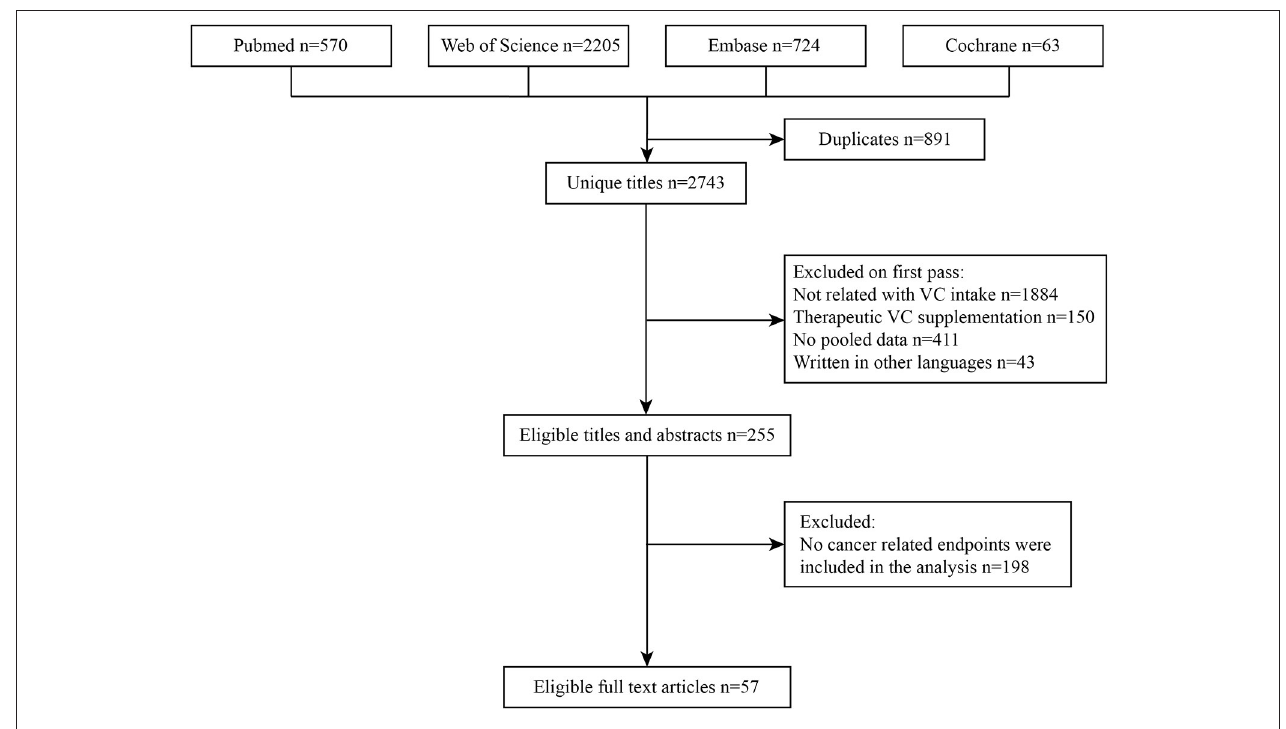
FIGURE 1 | Flowchart of the systematic search and selection